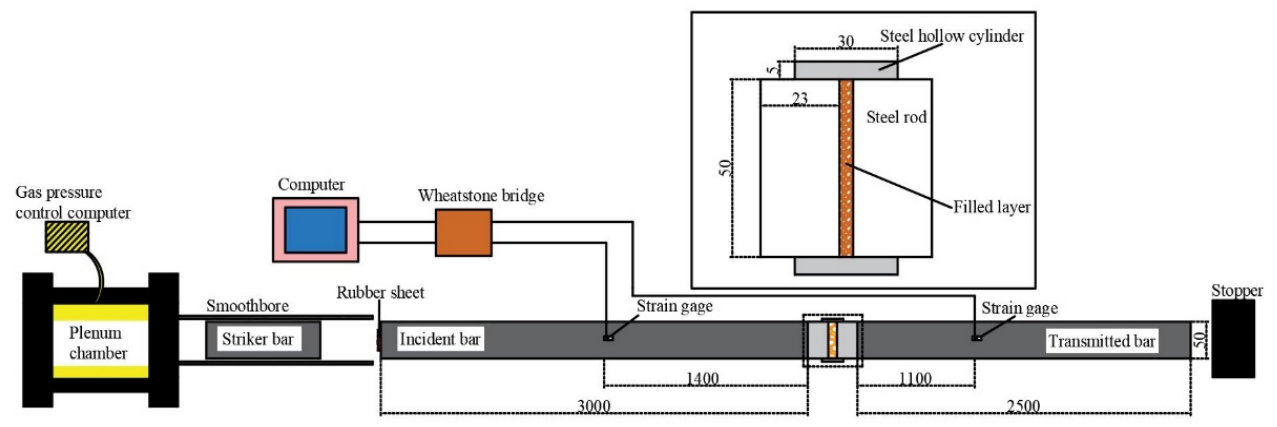
Figure 1. Split Hopkinson Pressure Bar.